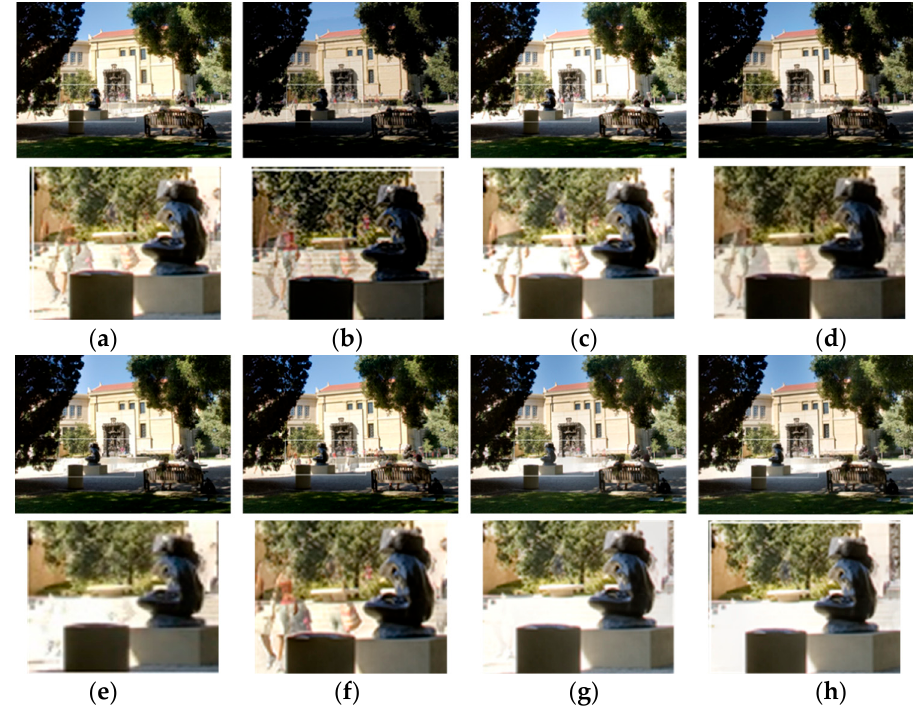
Figure 9. Results of different methods on the image sequence “Garden”. ( a ) Mertens et al. [12]. ( b ) Shen et al. [18]. ( c ) DE-MEF [20]. ( d ) Photomatix [36]. ( e ) Hayat et al. [21]. ( f ) Huang et al. [22]. ( g ) MBLBP-1. ( h ) MBLBP-2.